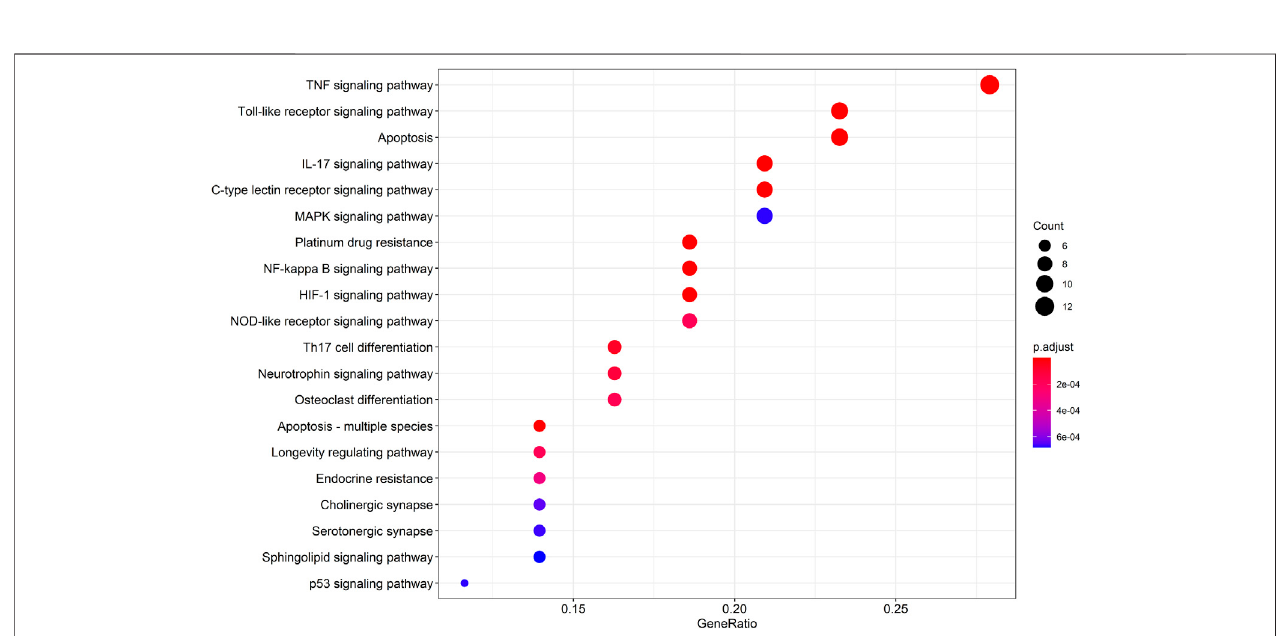
FIGURE 5 | The top 20 remarkably enriched KEGG analysis for the signaling pathway of potential target genes of WP in RA.